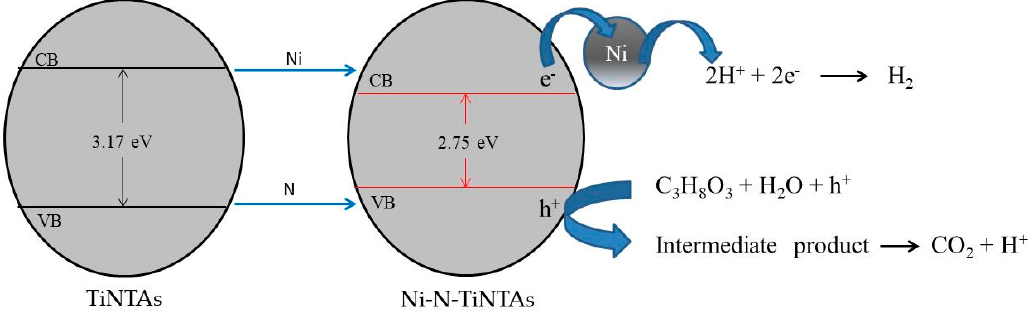
Figure 8. The mechanism of photocatalytic hydrogen production using Ni-N-TiNTAs.